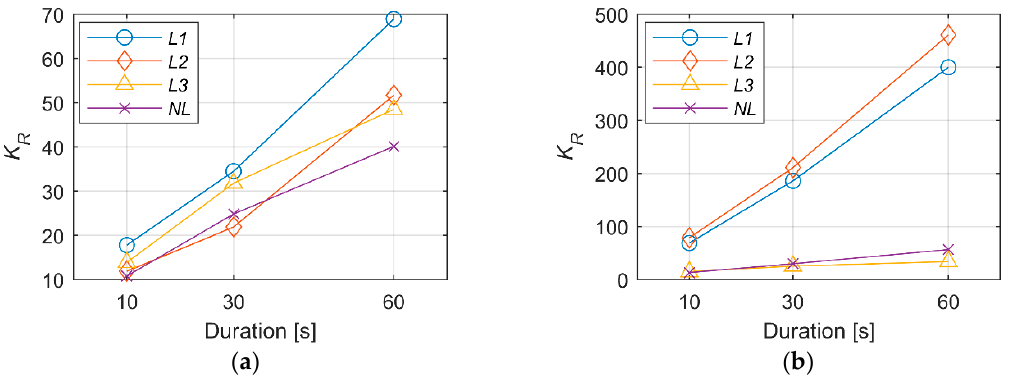
Figure 6. Trend of K R as function of the acquisition duration for Ard signals: ( a ) Test-1; ( b ) Test-2.